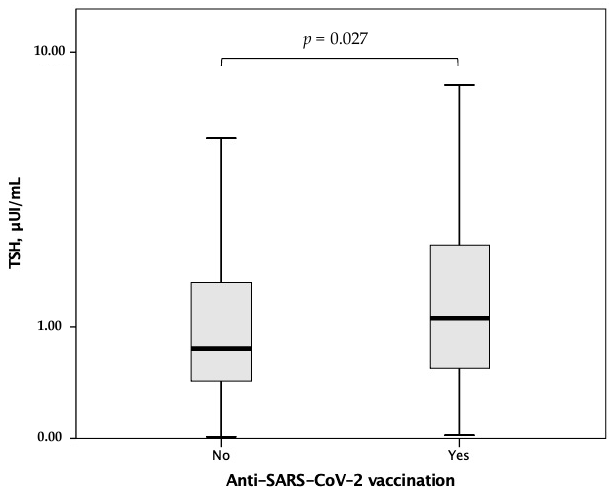
Figure 4. TSH levels according to anti-SARS-CoV-2 vaccination. TSH, thyroid-stimulating hormone. Statistical significance was assessed through the Mann–Whitney U-test.